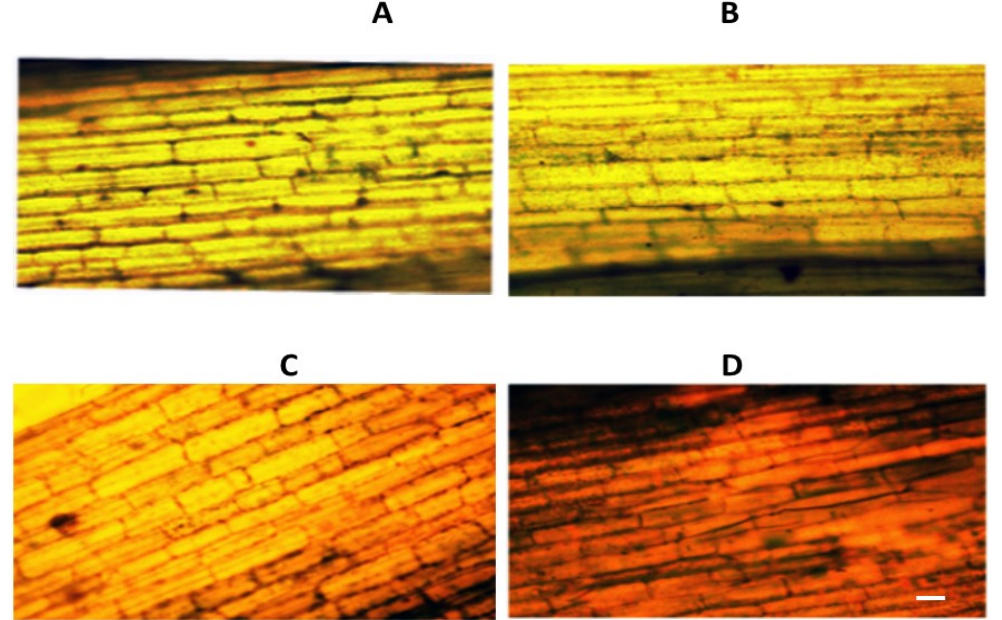
Figure 6. Trypan blue staining of coleoptile of 10-day seedlings differing in the number of dead cells. ( A , B )—Orenburgskaya 22; ( C , D )—Zolotaya; ( A , C )—control; ( B , D )—150 mM NaCl. Bar 400 μ m.